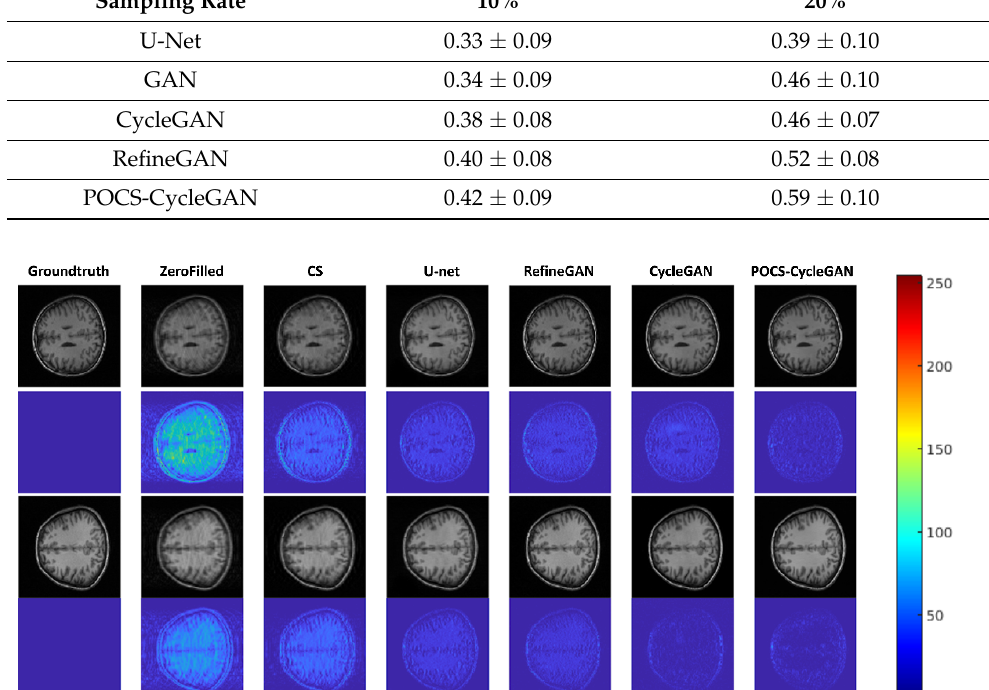
Table 2. SSIM (mean standard deviation) of different methods with different sampling rates for the NYU dataset.